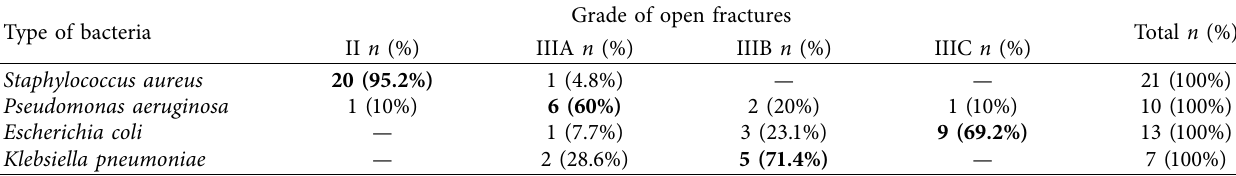
Grade of open fractures